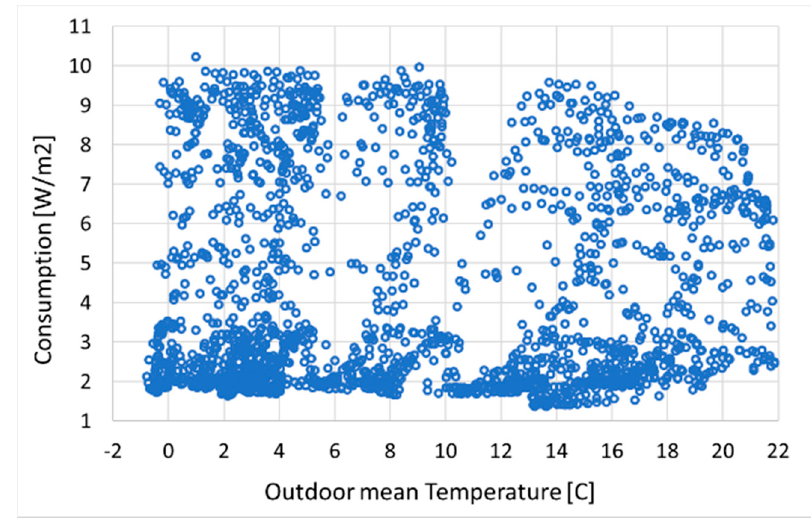
Figure 11. Daily consumption vs. average outdoor temperature.